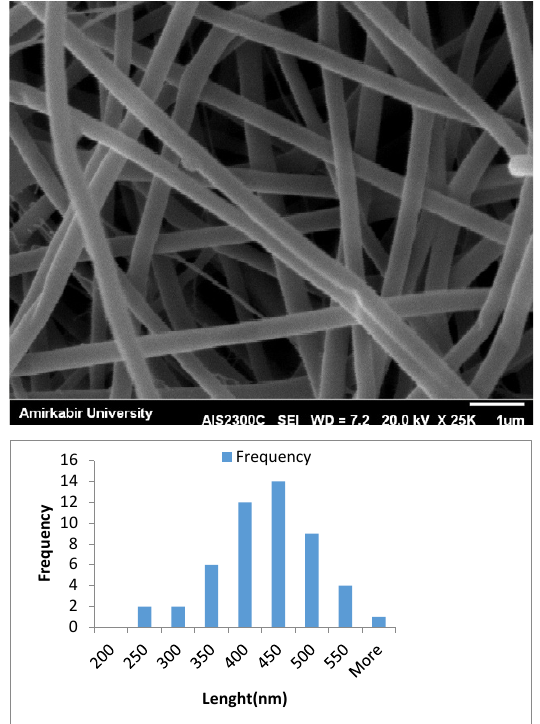
Fig. 4. SEM image of PVA/CS/ CeAlO electrospun nanofibers before cross-linking process average nanofibers diameter (412 3